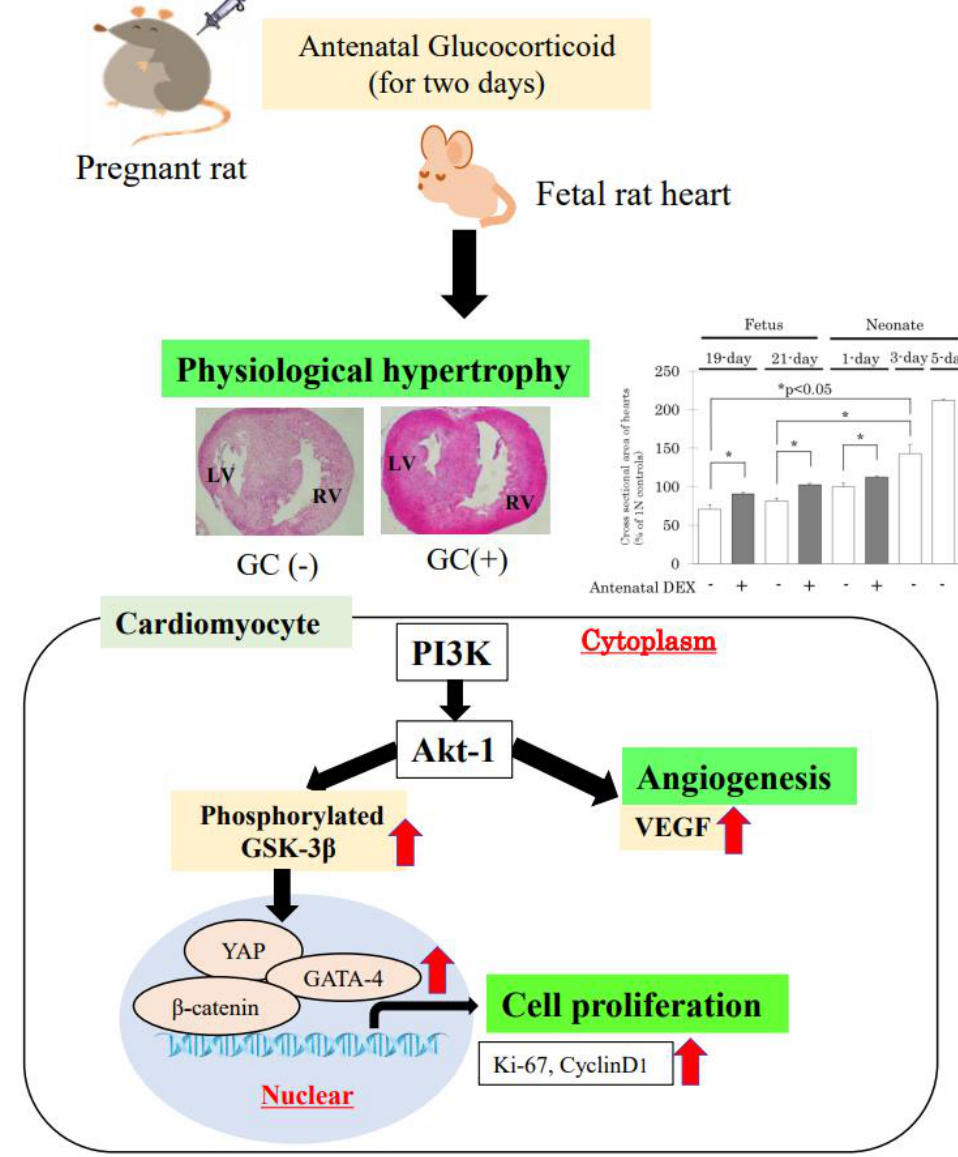
Figure 1. Schematic diagram of cell proliferation and angiogenesis. Pregnant rats are administered glucocorticoids (GCs) subcutaneously for two days, on gestational days 17 and 19, and fetuses are delivered by cesarean section. On histological analysis, the cross-sectional area of the myocardium is smaller in 19-day-old fetuses than in neonates. Physiological hypertrophy is induced by cardiac cell proliferation and angiogenesis. Antenatal GC administration enhances phosphatidylinositol-3 kinase (PI3K), which activates Akt-1. Moreover, Akt-1 accelerates both phosphorylated glycogen synthase kinase-3 β (p-GSK-3 β ) and vascular endothelial growth factor (VEGF) expression. Subsequently, p-GSK-3 β contributes to the activation of cardiomyocyte proliferation factors, β -catenin, Yes-associated protein (Yap), and GATA-4. Accordingly, cell proliferation markers, Ki-67 and cyclin D1, are increased in the nuclei of fetal cardiomyocytes. GATA binding protein, GATA.